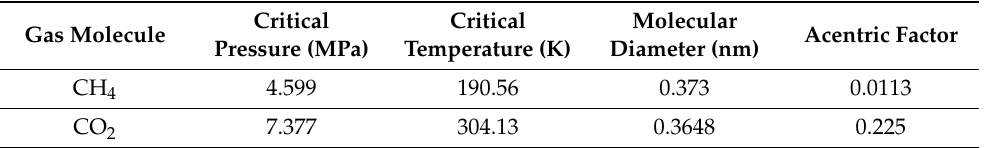
Figure 1. Calculation workflow based on multicomponent SLD model for competitive adsorption of the CH 4 /CO 2 binary mixture. Table 1. Physical properties of CH 4 and CO 2